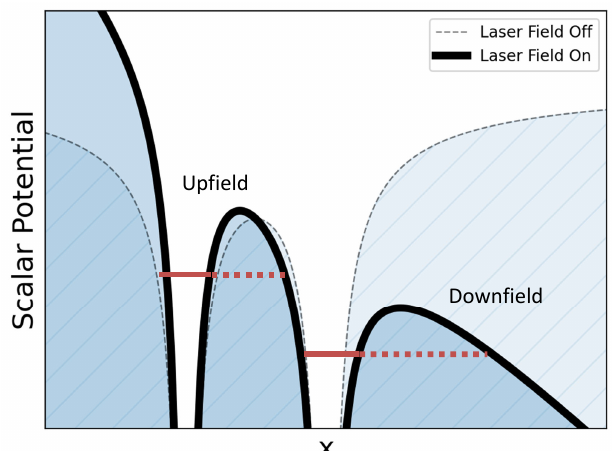
Figure 1. Schematic of the electric potential created by a diatomic molecule with and without a strong laser field present. Turning on the laser electric field allows electrons originating from both atomic sites to tunnel into the continuum. Upfield and downfield electrons experience different potentials due to the molecule’s asymmetric Coulomb forces, altering their